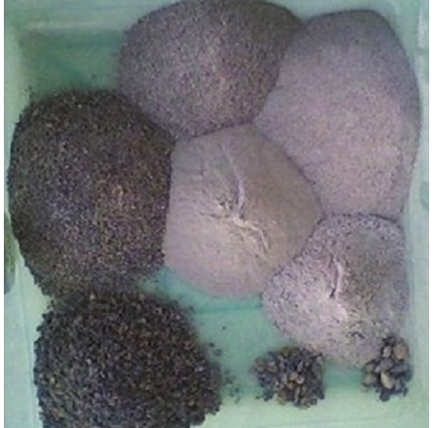
Figure 1: Different size fractions of quarry dust.